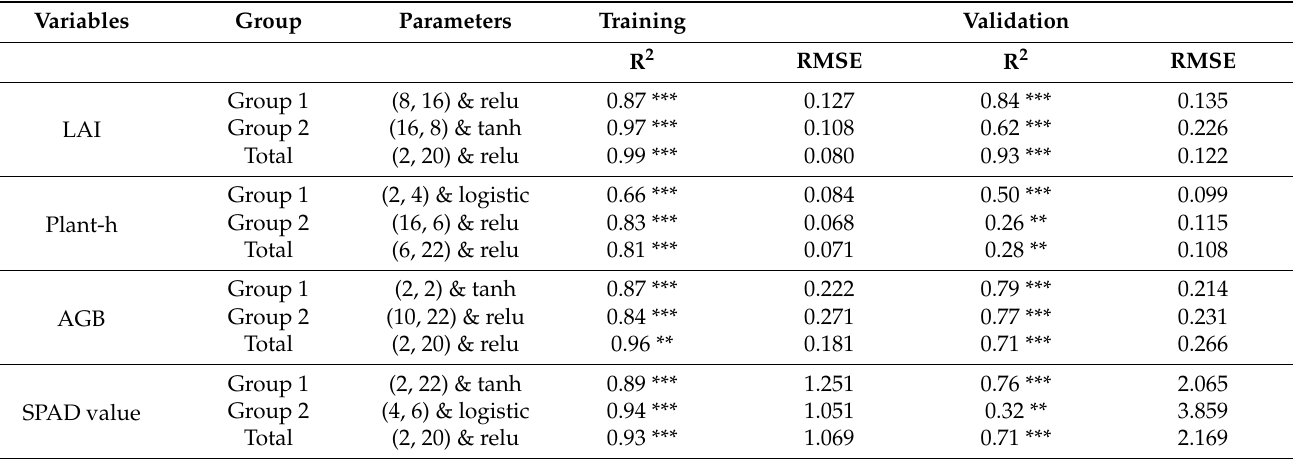
Table 8. Outcomes of calibration and validation models of ANN for the association between V-SRIs extracted from in situ spectrometry and satellite imagery and leaf area index, plant height, above ground biomass and SPAD value prior selecting the best features.